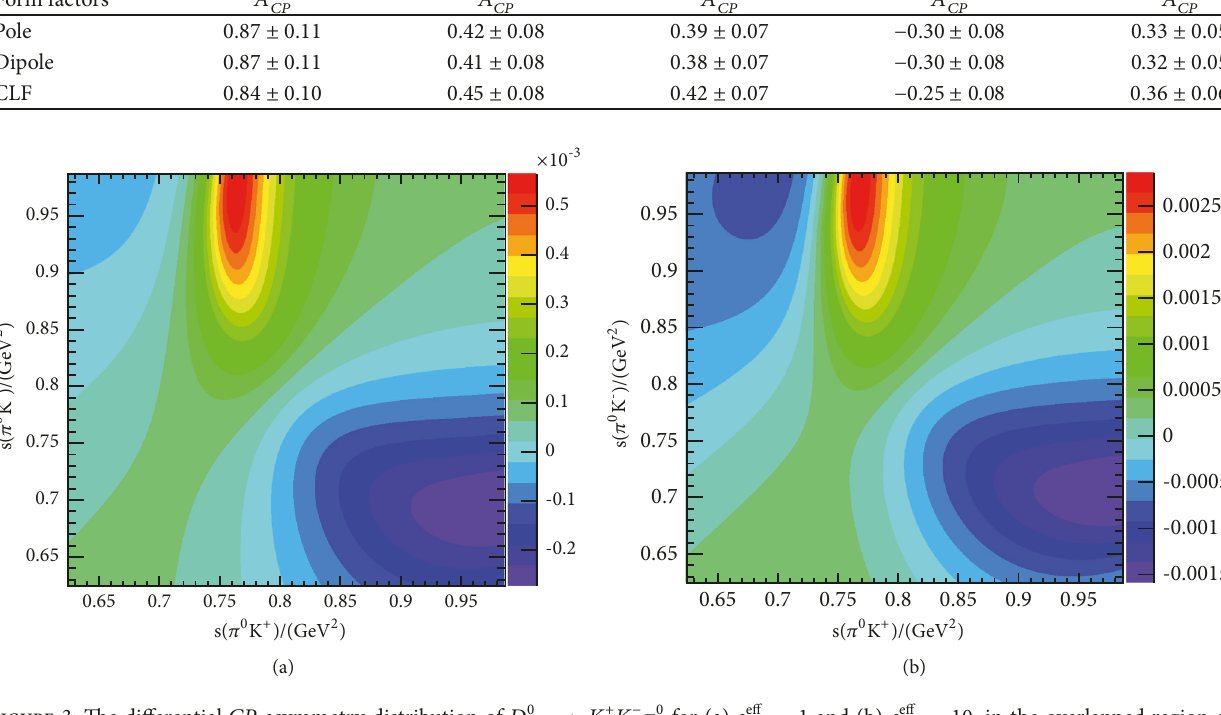
Figure 3: The differential 𝐶𝑃 asymmetry distribution of 𝐷 0 󳨀→ 𝐾 + 𝐾 − 𝜋 0 for (a) 𝑐 eff 8𝑔 = 1 and (b) 𝑐 eff 8𝑔 = 10 , in the overlapped region of 𝐾 ∗ (892) − and 𝐾 ∗ (892) + in the phase